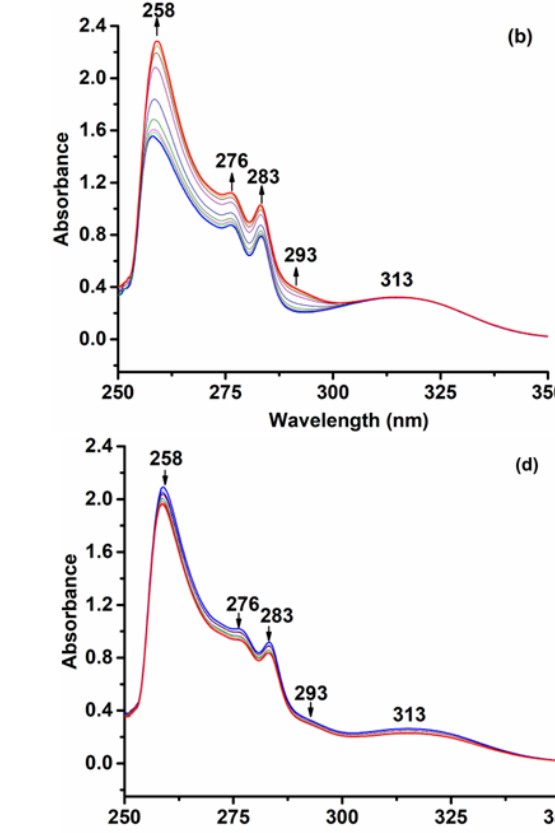
Figure 8. 51 V NMR spectrum of complex 1 in DMSO-d 6 ( a ) and after the addition of 40 equivalent of H 2 O 2 to DMSO-d 6 solution of complex 1 ( b ).